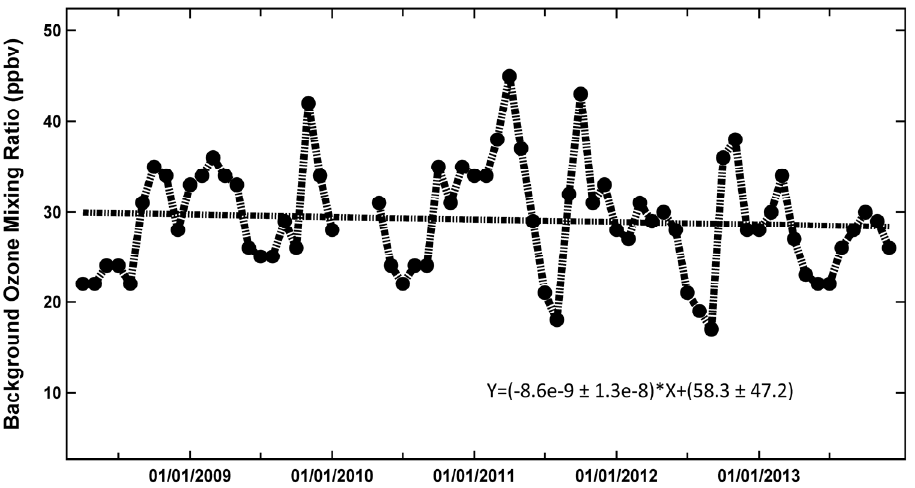
Figure 1. Monthly averaged background O 3 mixing ratios measured atop Moody Tower on the University of Houston